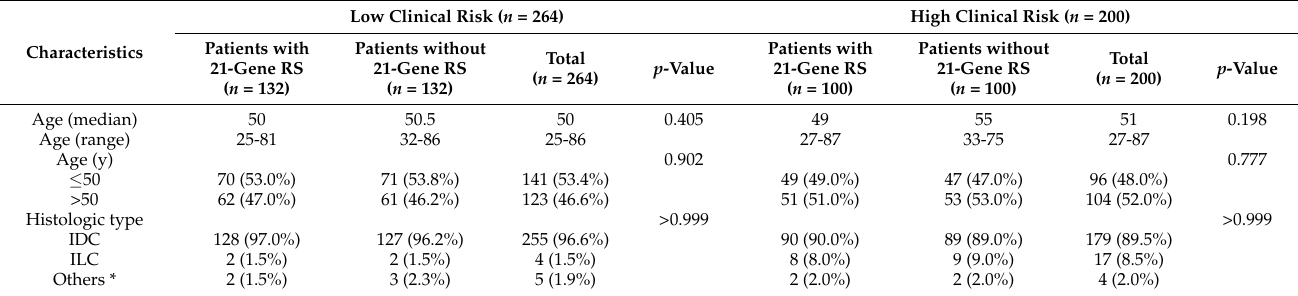
Table 1. Baseline characteristics according to clinical risk stratified by 21-gene RS use in the propensity-score matched cohort.